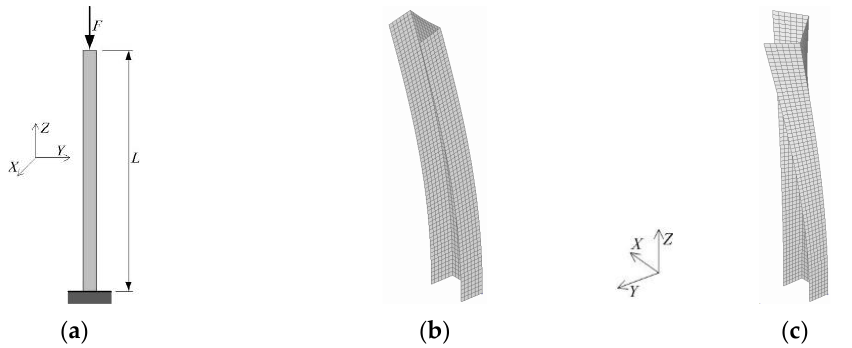
Figure 4. Simply supported column: ( a ) geometry, ( b ) flexural buckling mode, and ( c ) torsional- flexural buckling mode.